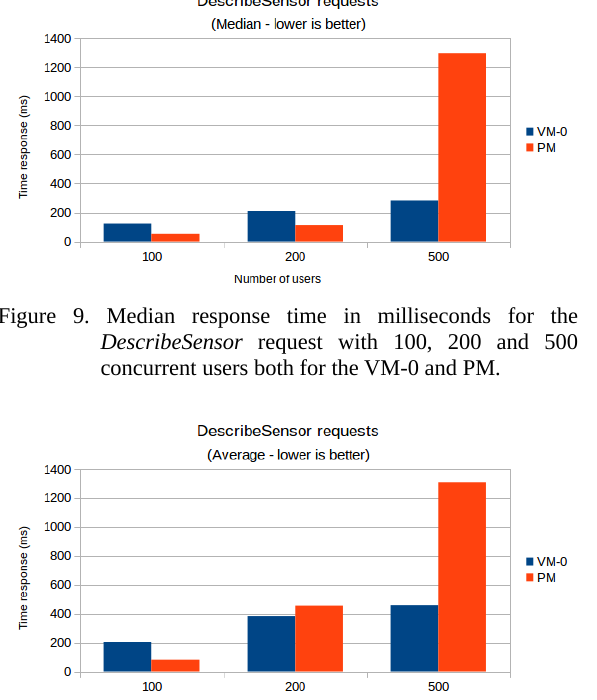
Figure 6. Number of total requests with 100, 200 and 500 concurrent users both for the VM-0 and PM.